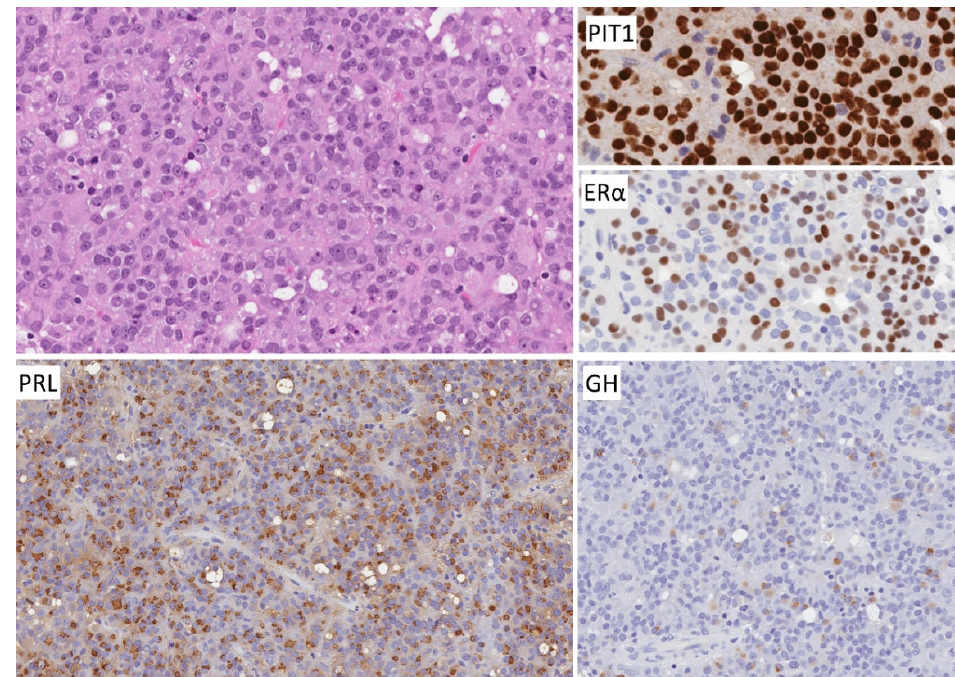
Figure 9. Morphology of acidophil stem cell tumor. This oncocytic tumor of PIT1 lineage has a char- acteristic histology with abundant, granular, pale acidophilic cytoplasm and scattered cytoplasmic vacuoles that represent dilated giant mitochondria. Tumor cells express nuclear PIT1 and ER α . There is extensive staining for PRL that shows a predominant juxtanuclear globular pattern of staining that corresponds to the Golgi region. Scattered tumor cells also express GH, explaining the development of variable GH excess in patients with these tumors.